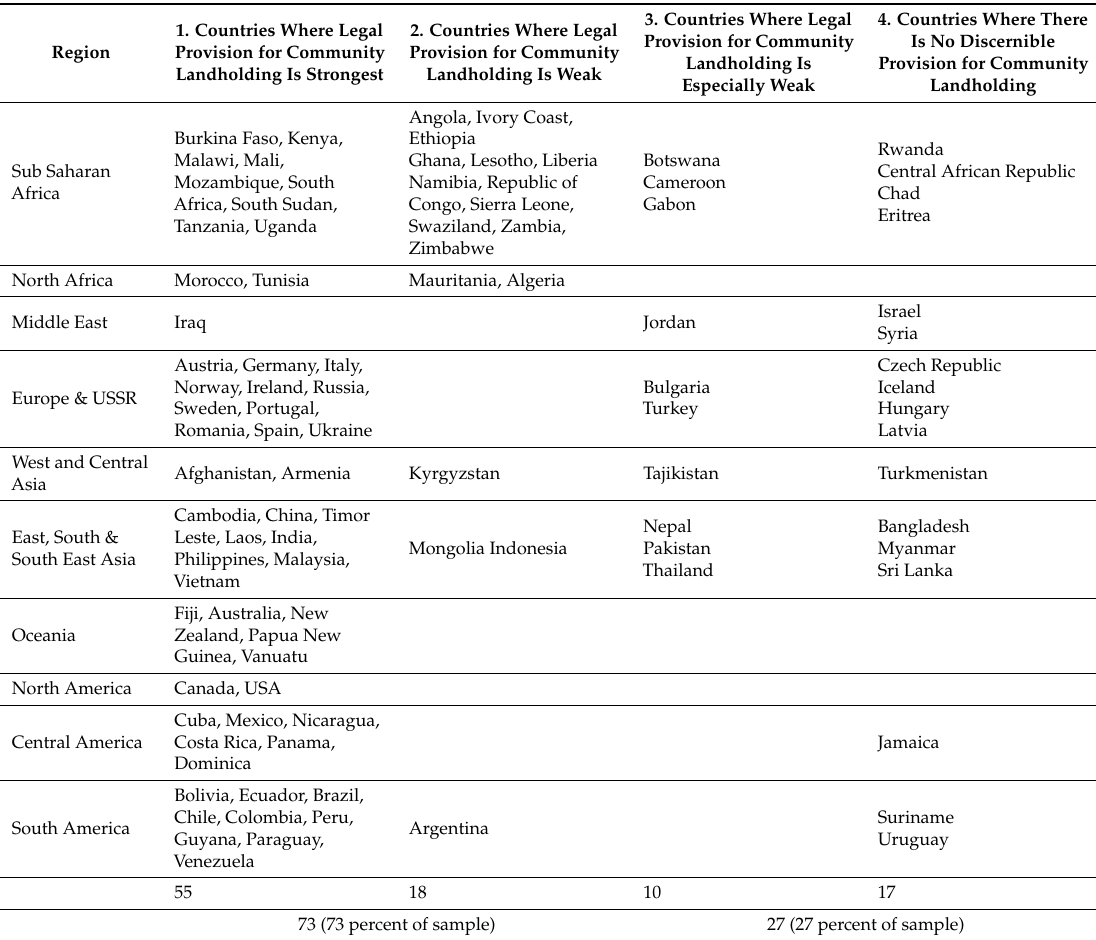
Table 3. Countries where laws provide for community property presented by region.